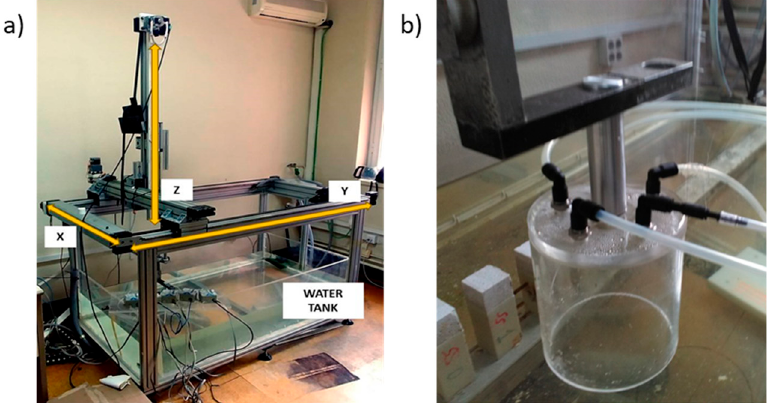
Figure 3. ( a ) Automatic motion system and ( b ) air pressure chamber.